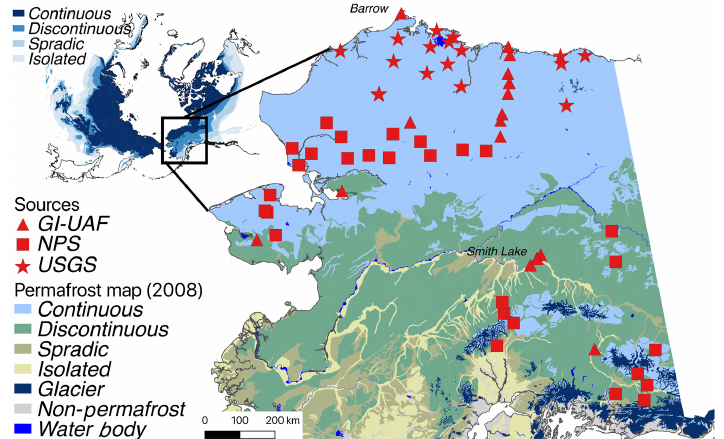
Figure 1. Locations of the Geophysical Institute at the University of Alaska Fairbanks (GI-UAF), the U.S. Geological Survey (USGS), and the National Park Services (NPS) permafrost monitoring stations in Alaska. The basemap shows the permafrost distribution of Alaska compiled by Jorgenson et al.